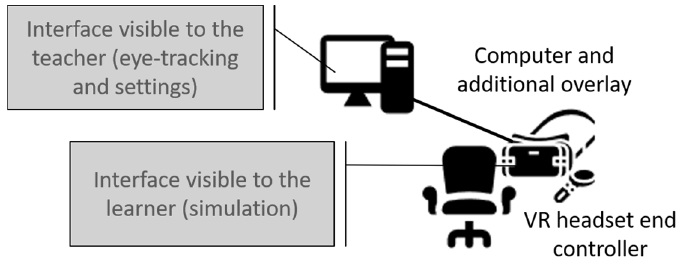
Figure 1. Training simulator architecture.